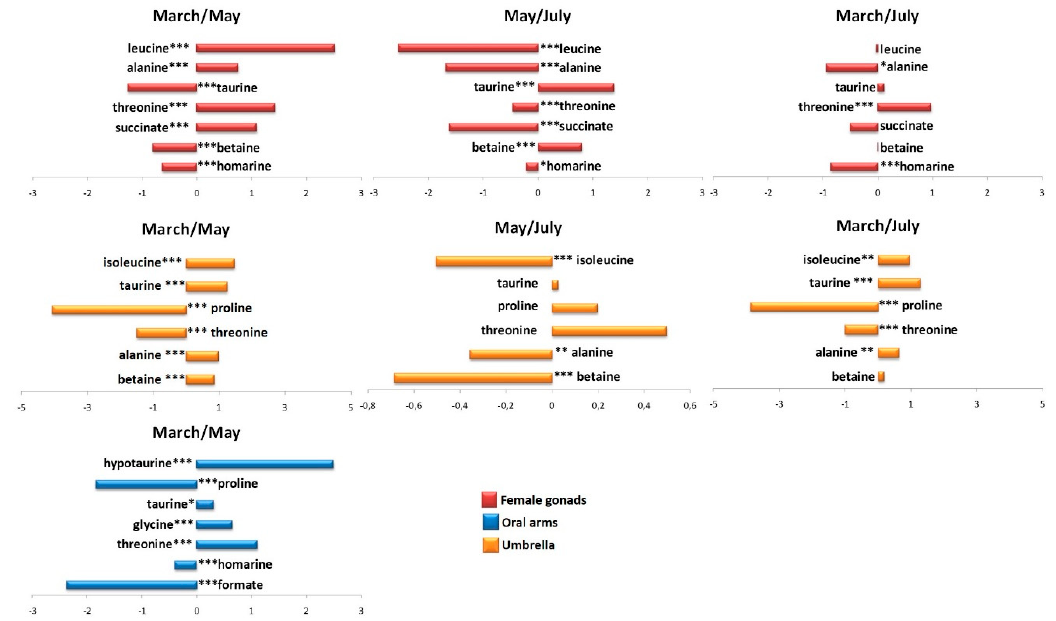
Figure 10. Variation in discriminating metabolites content for each compartments, among the different sampling (March, May, and July). Signif. codes: ‘***’ 0.001 ‘**’ 0.01 ‘*’ 0.05 ‘.’ 0.1 ‘ns ‘ 1.